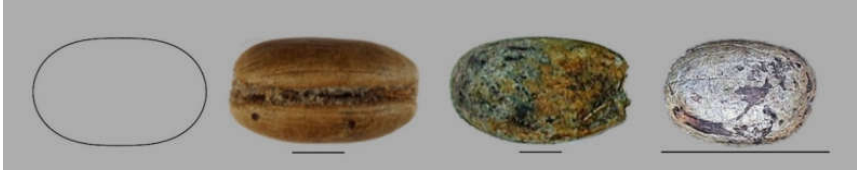
Figure 6. Representative examples of seeds, whose images adjust well to different ovals, ( J index values are indicated between parentheses). From top to bottom (more to less elongated): Serenoa repens (90.0), Desmoncus sp. (93.6), Astrocaryum standleyanum (91.5), and Medemia argun (92.1). The ovals correspond to the equations given in the text. Bars represent 0.5 cm.